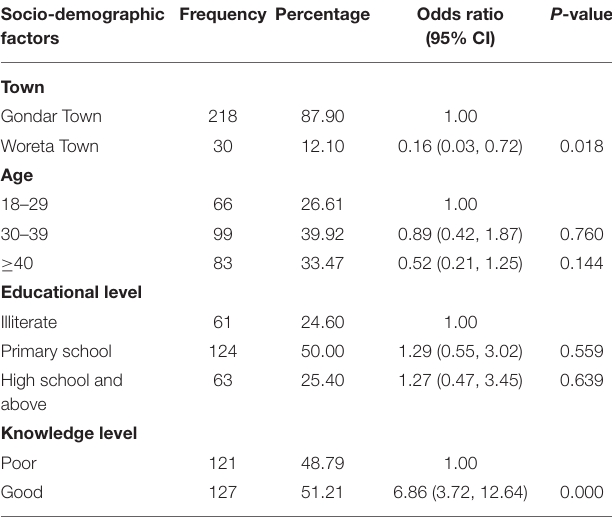
TABLE 8 | Factors influencing practice level of the respondents related to epizootic lymphangitis.